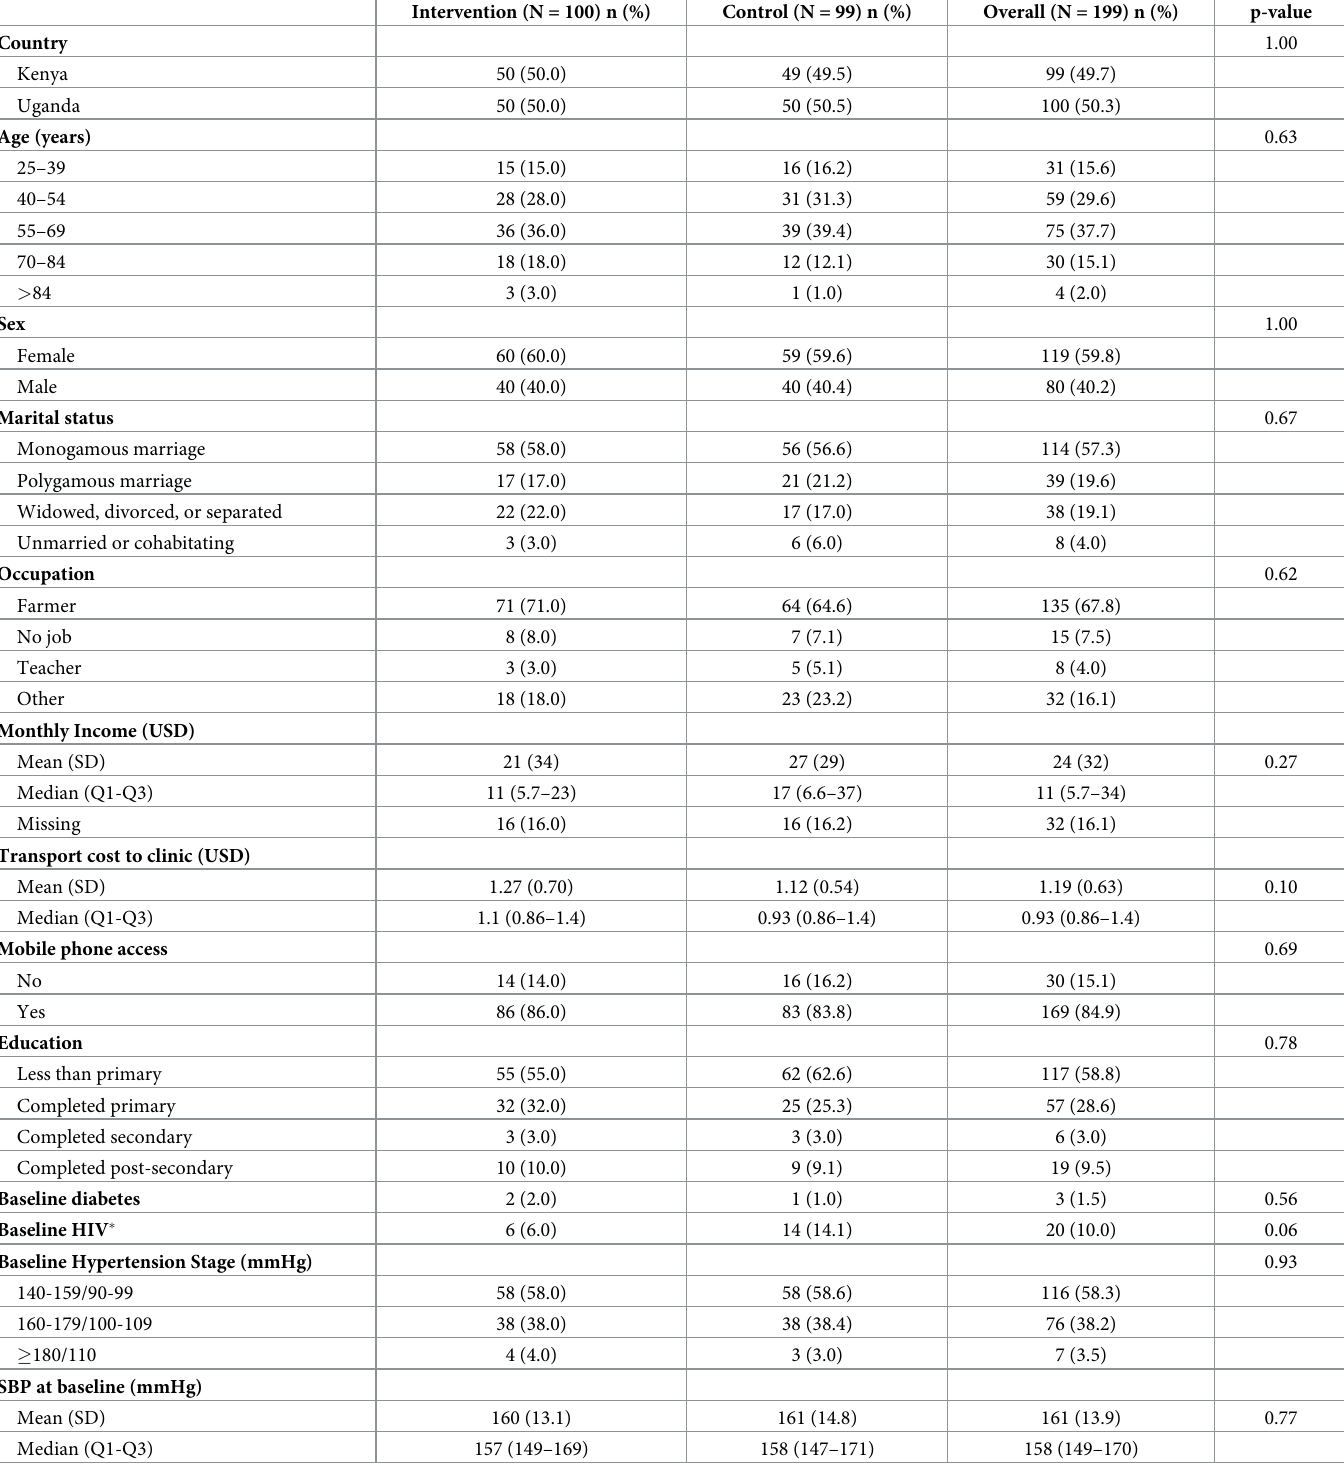
Table 1. Baseline